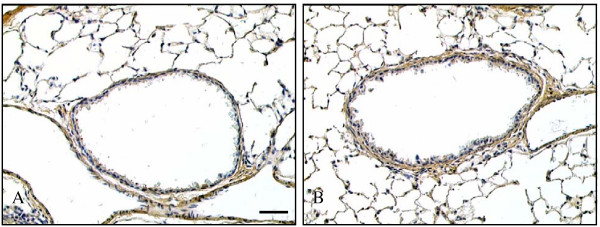
The effect of ovalbumin sensitisation and challenge on airway sub-epithelial deposition of type III collagen. Immunostaining of representative saline sensitised/challenged (A)and ovalbumin sensitised/challenged (B) airways for type III collagen 12 days after final challenge. In control lungs staining was localised to the alveolar septa, airway and vessel walls. Airway sub-epithelial staining was increased following ovalbumin sensitisation/ challenge. Scale bar represents 50 μm.